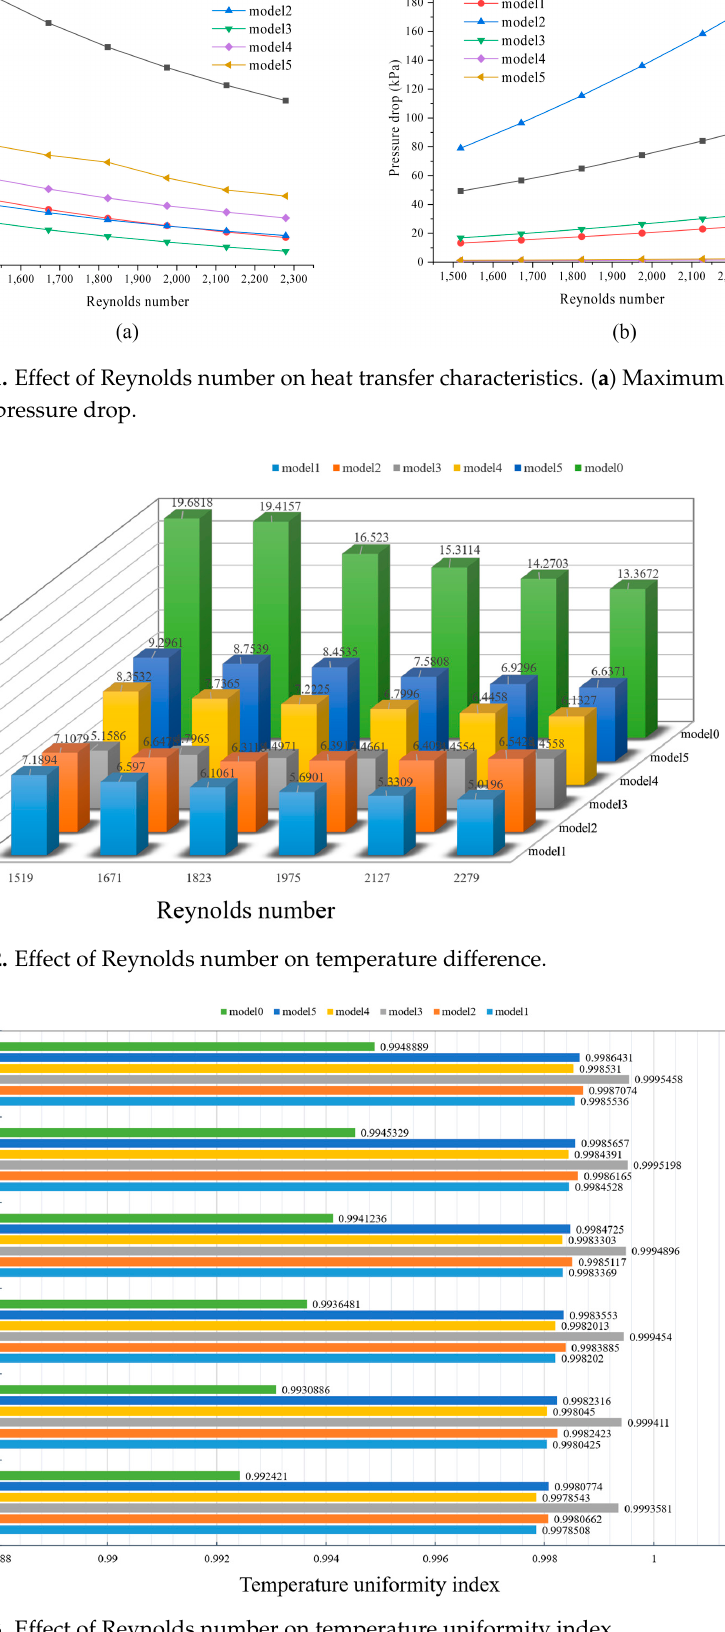
Figure 13. Effect of Reynolds number on temperature uniformity index. 3.5. Flow Distribution Improvement It can be found from Figure 14a that the center temperature of the multi-serpentine cooling plate is high due to the transfer of heat from the inlet to the outlet and the winding